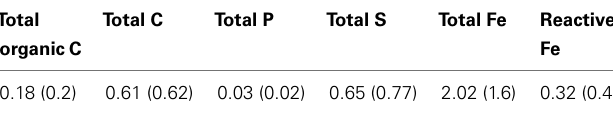
Table 1 | Geochemical solid phase analysis of 48 sediment samples.